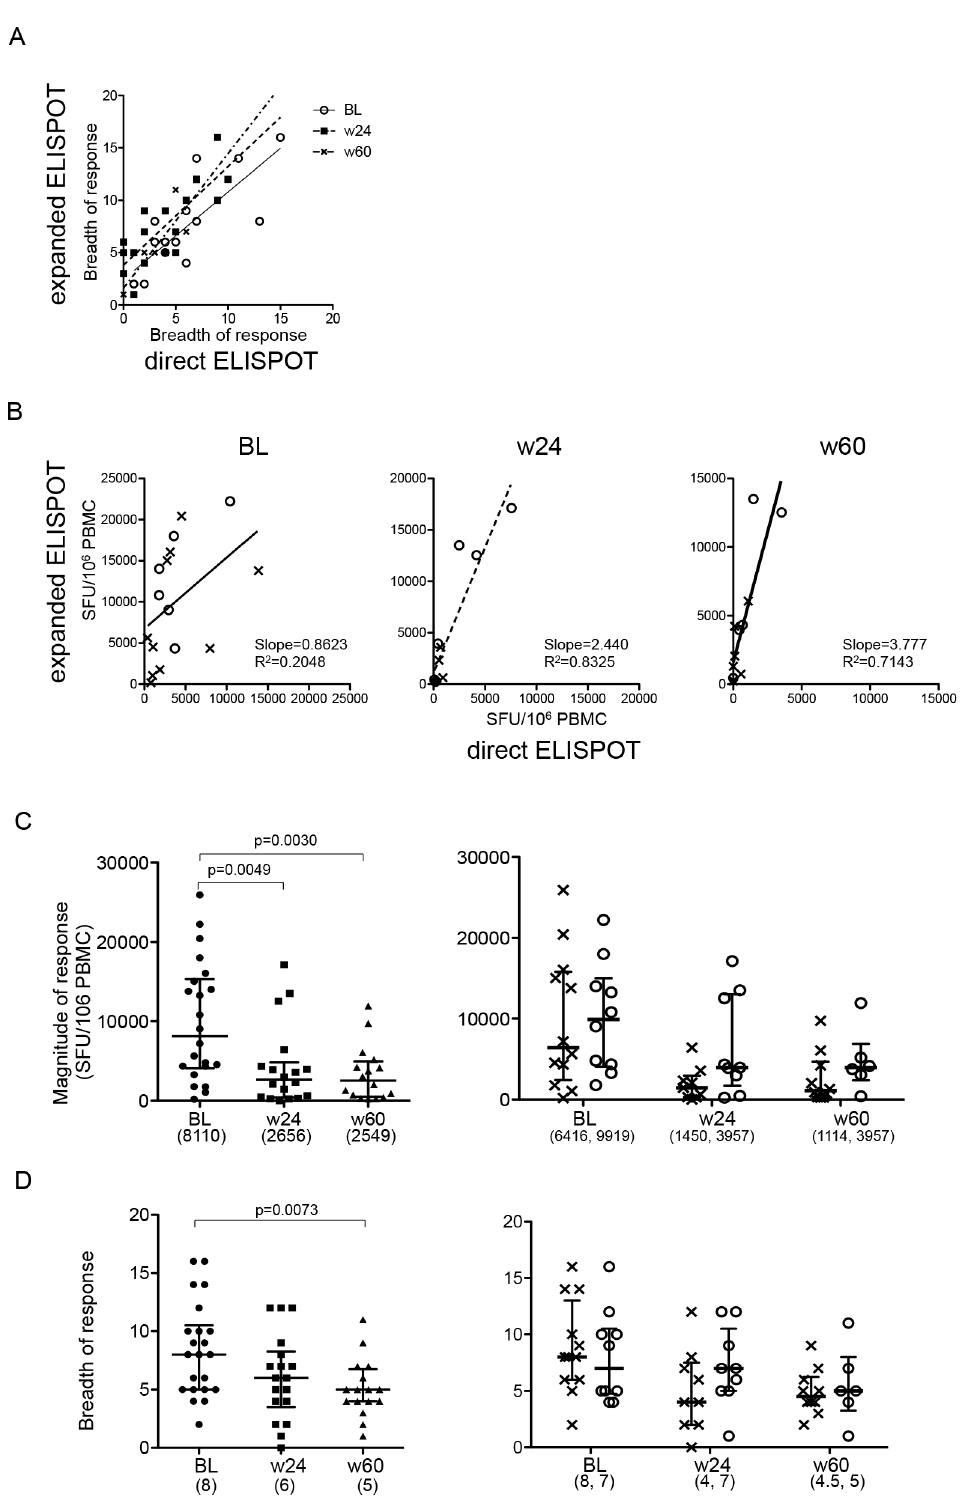
Figure 3. Longitudinal assessment of HIV-specific T cell responses with invitro expanded T cells. A. Relationship of the breadth between responses detected by direct ELISpot and ELISpot using in vitro expanded cells. Responses on the x-axes represent the total HIV-1-specific responses in direct ELISpot, and the y-axes indicate total HIV-1-specific responses in expanded ELISpot for samples taken at baseline (circle), week 24 (square), and week 60 (triangle). B. Relationship of the magnitude between direct ELISpot and expanded ELISpot at each time point. cross: control arm, circle: MVC arm. The lines in A and B show linear regression lines. C, D. Changes in magnitude and breadth of total HIV-specific T cell responses in expanded ELISpot are shown as in Figure 2.